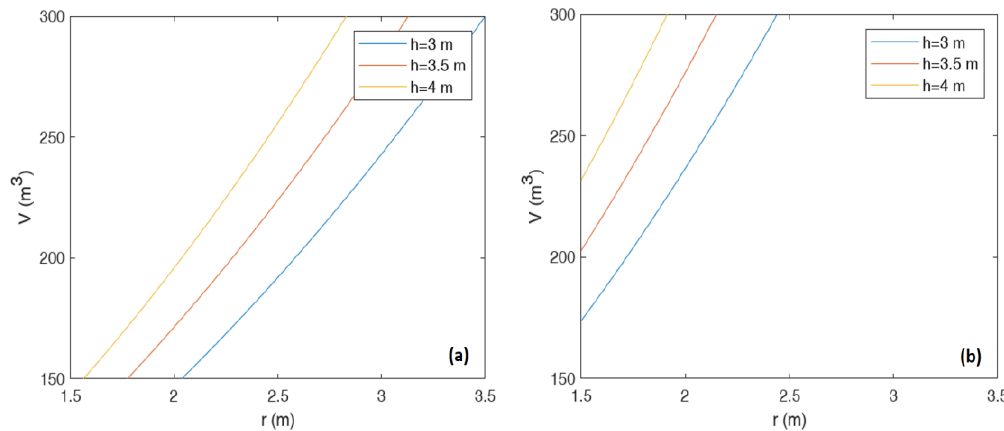
Figure 2. Graph of the correlation between volume ( V ) and source-receiver distance ( r ), for different heights of the classrooms, within a: ( a ) Square-shaped classroom; ( b ) Rectangular-shaped class- room.